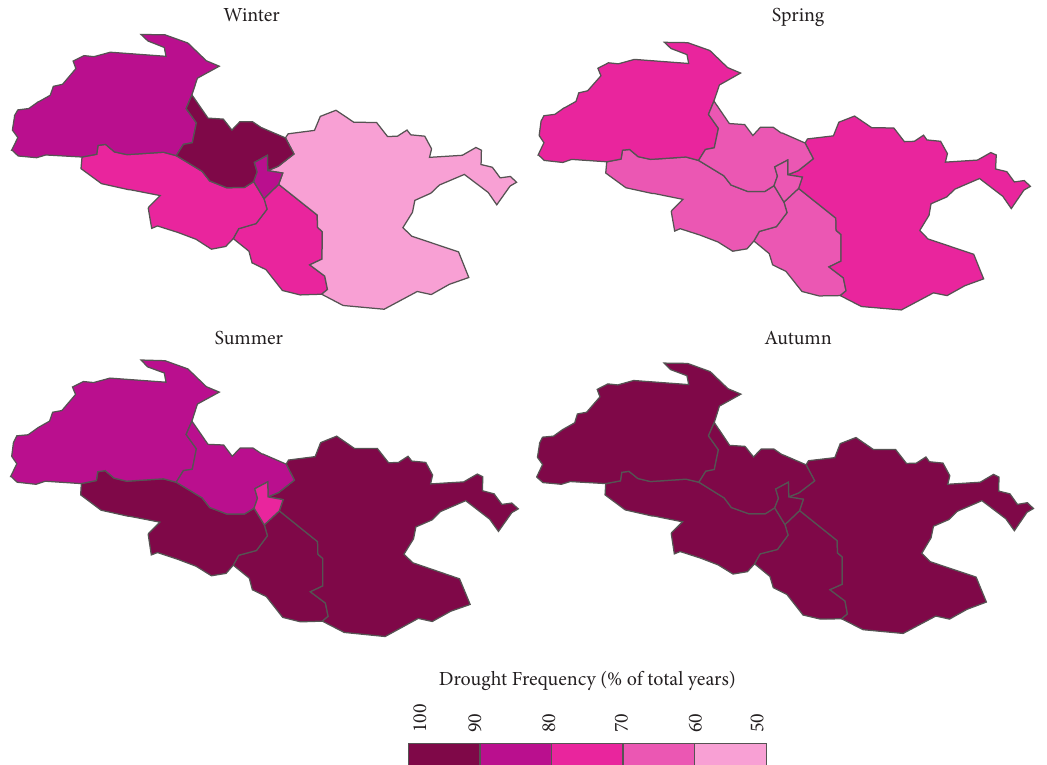
Figure 7: Seasonal drought frequency for each selected station as a percent of total (1971–2017) years.